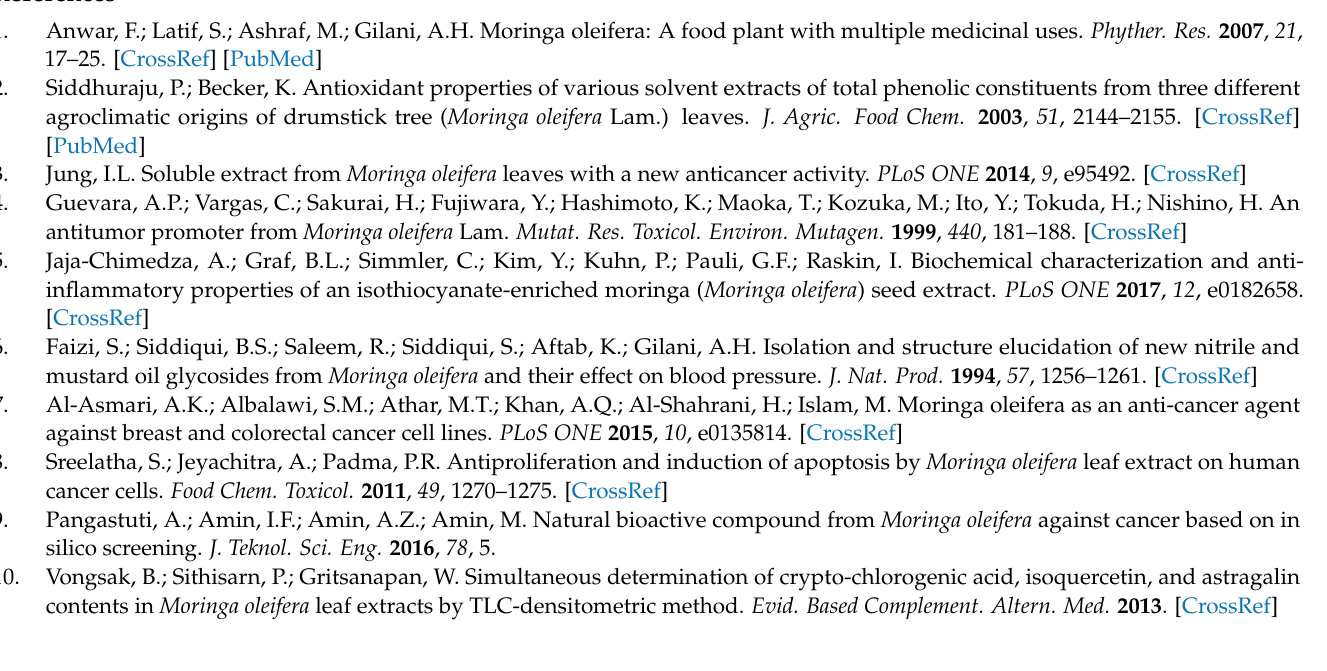
point harvesting, Figure S4: PLS-DA model validity permutation test for M. oleifera (cultivar PKM1) metabolite profile under low, intermediate and high harvesting frequencies, Table S1: 1H-NMR spectral regions of annotated compounds that contributed to the separation of leave